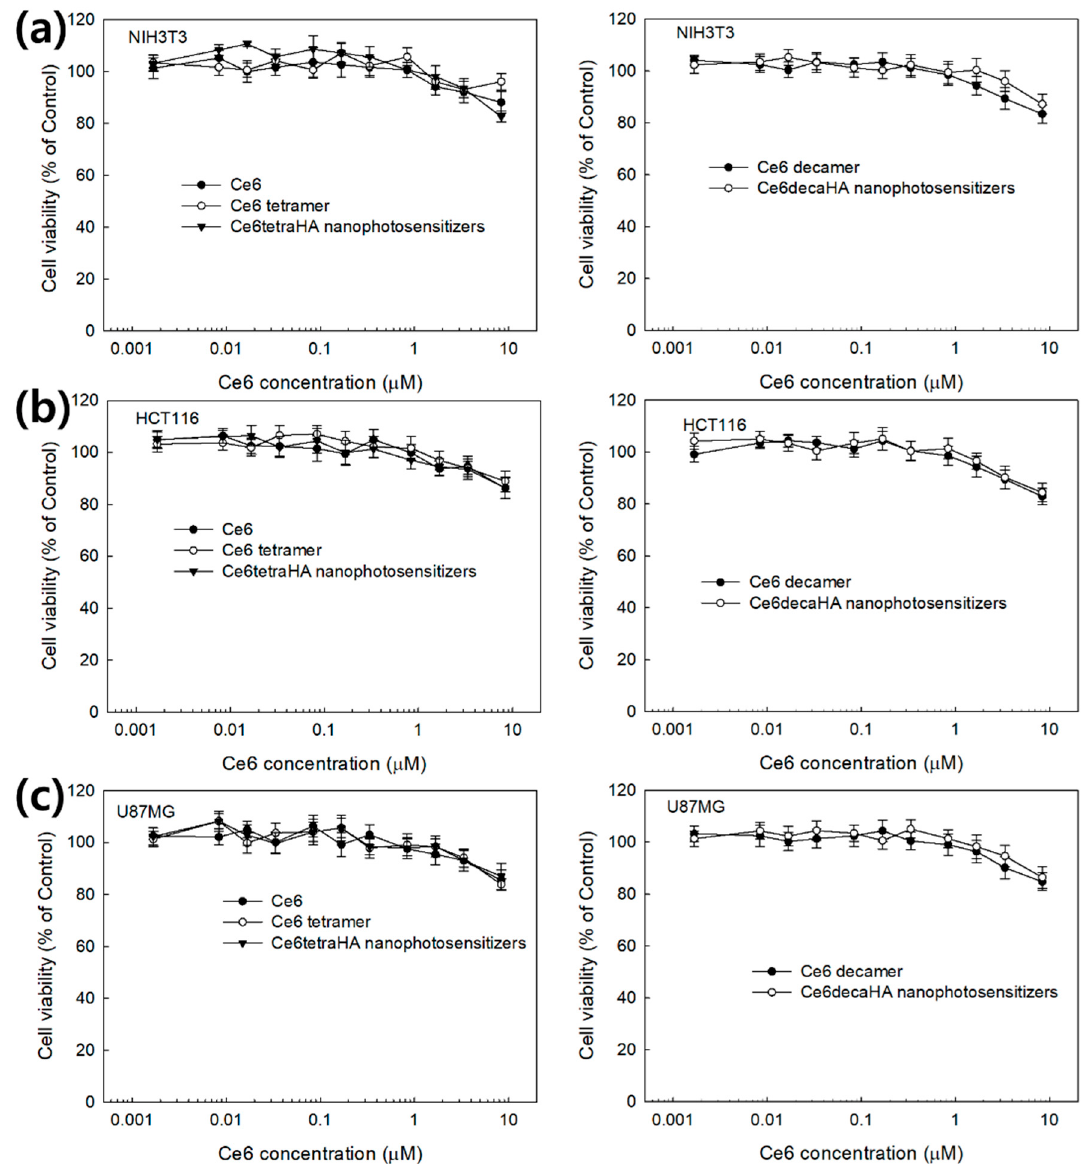
Figure 6. Dark toxicity of Ce6, Ce6tetraHA and Ce6decaHA nanophotosensitizers against NIH3T3 mouse fibroblast cells ( a ), HCT116 human colon carcinoma cells ( b ) and U87MG human malignant glioma cells ( c ). All the values are average ± S.D. from results of a single independent experiment with eight replicate.